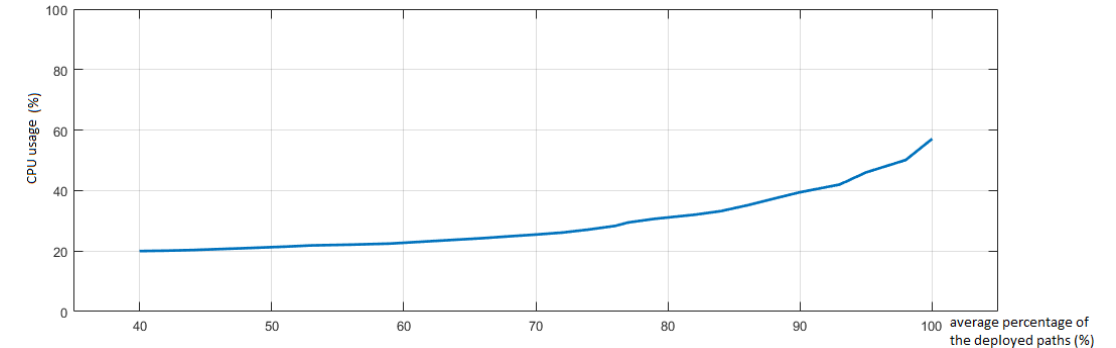
Figure 29. Computational